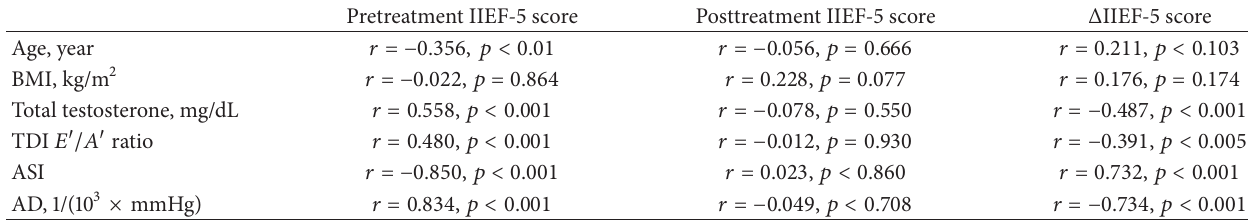
Table 2: Correlation analyses results of the subjects’ data and IIEF-5 scores were expressed.